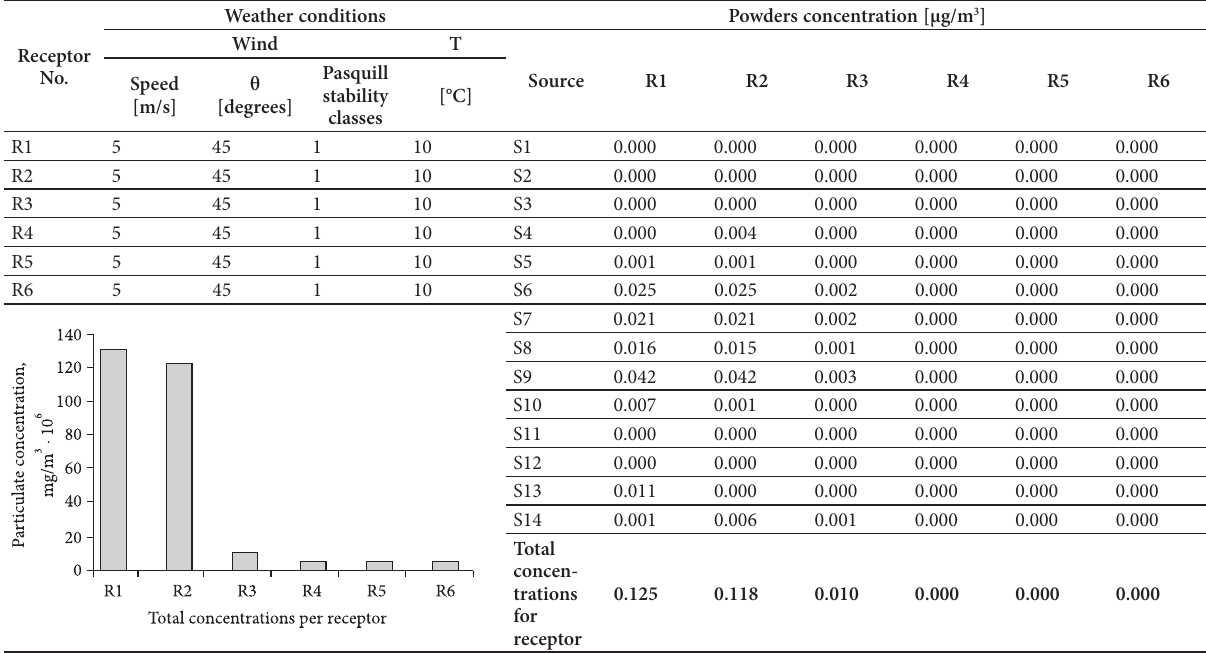
Fig. 2. Data and graphical representation for distribution of powders emissions from the 14 sources in “highly unstable” atmospheric conditions